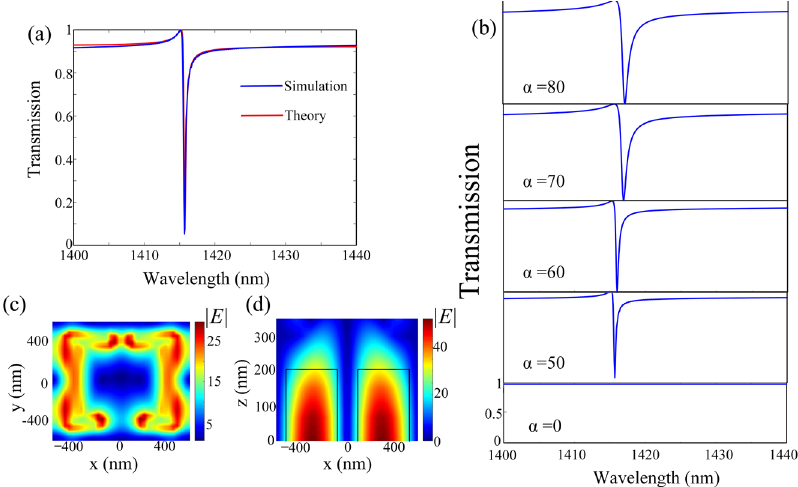
Figure 2. ( a ) The simulated and theoretically fitted transmission spectra of the proposed metasurface with the asymmetry parameter α = 50. ( b ) The transmission spectra of the proposed metasurface with different asymmetry parameter α. The distributions of |E| of ( c ) top and ( d ) cross section of the structure at the resonance wavelength (λ = 1415.68 nm), respectivel y.